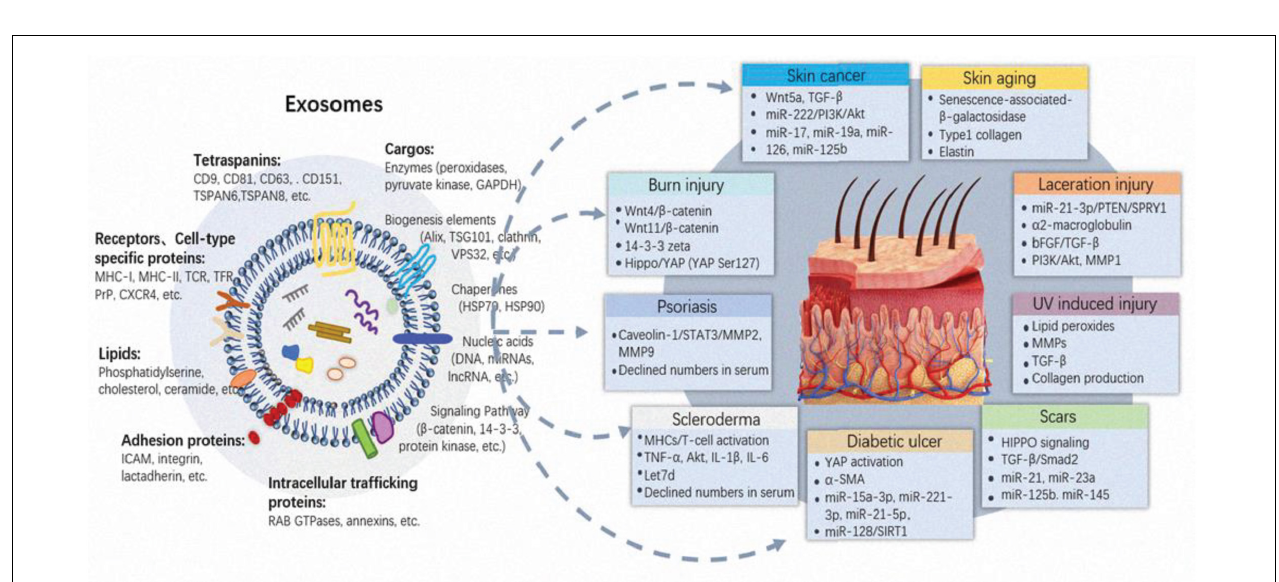
FIGURE 2 | Main composition of exosomes and their functions on skin injuries. Despite the different origin and mode of biogenesis, exosomes display a similar appearance, and common composition. Exosomes are featured by tetraspanins, receptors or cell-type specific proteins, lipids, adherin proteins, intracellular trafficking proteins. Deep analysis of extracellular vesicle composition reveal that they convey various cargoes, including nucleic acids, proteins (biogenesis elements, chaperones and signaling pathway molecules) and lipids, which all vary widely between cells and conditions. The vast information will directly affect the fate and function of exosomes in skin injuries. Exosomes participate in multiple cutaneous diseases including laceration, burn, aging, diabetic wound healing, scar formation, skin autoimmune disease and skin cancers, through different biological